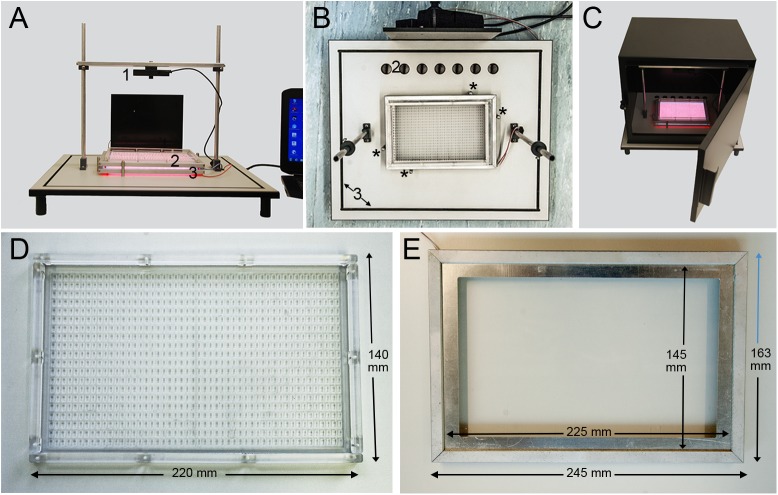
Setup of the WEclMon.A, B) The monitor consists of a webcam (1) mounted on a z-variable stage above an eclosion plate (2) on which the puparia are glued. Illumination for the camera and light regimes is provided by light plates stacked below the eclosion plate (3) and kept in place by four metal pins (asterisks in B),. The whole setup is mounted on a board, and is connected to a laptop computer. B) The monitor with removed camera seen from top. At the rear, a black plastic housing holds a multiplug connector with power supplies for the light plates (1). Holes in the laminate base (2) allow for humidity exchange and wiring via a light-trap when the system is closed by the light-tight box during DD experiments (C). The light-tight box fits into a depression cut into the high-pressure laminate board (3 in B), and can be opened by a door which–when closed- is kept light-tight by a foam rubber lining. D) The eclosion plate with 1000 platforms. E) A light plate. The LED stripes surrounding the whole plate are covered by a metal frame and are thus not visible. The eclosion plate fits into the frame.